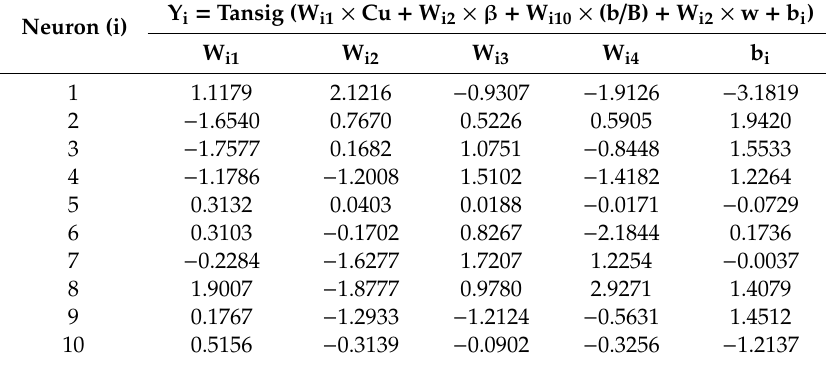
Table 7. Weight and biases of the ANN